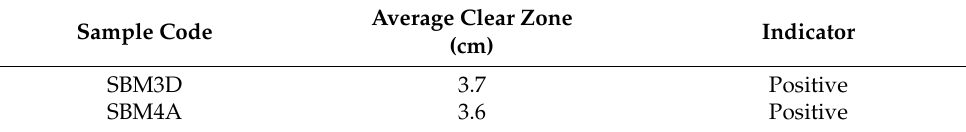
Table 2. Starch hydrolysis Activity of the LAB isolated from Wakawondu.